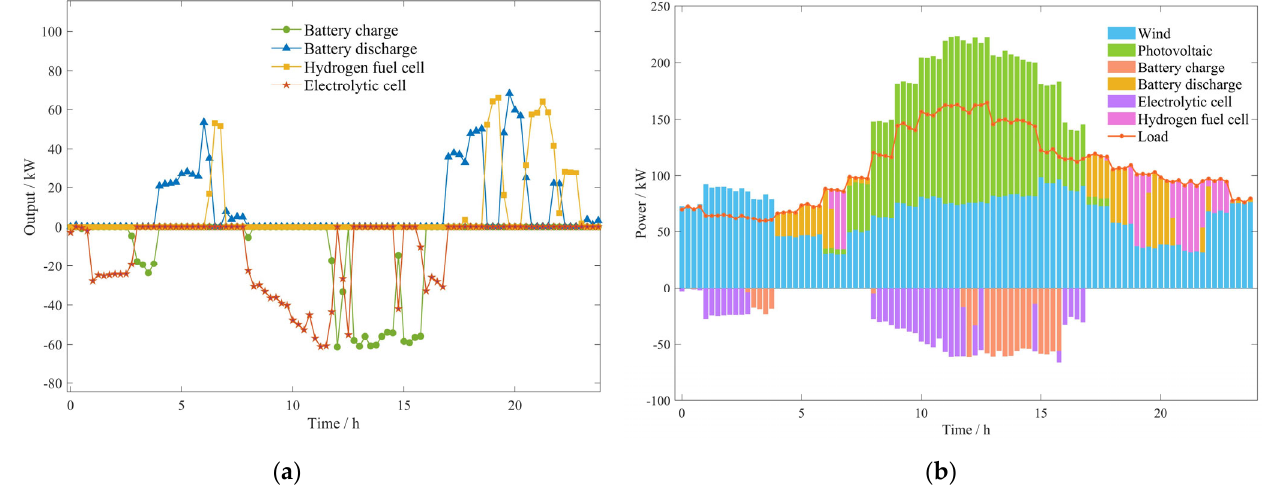
Figure 11. ( a ) Intra − day battery and hydrogen energy storage system output; ( b ) Intra − day opti- mized scheduling result.